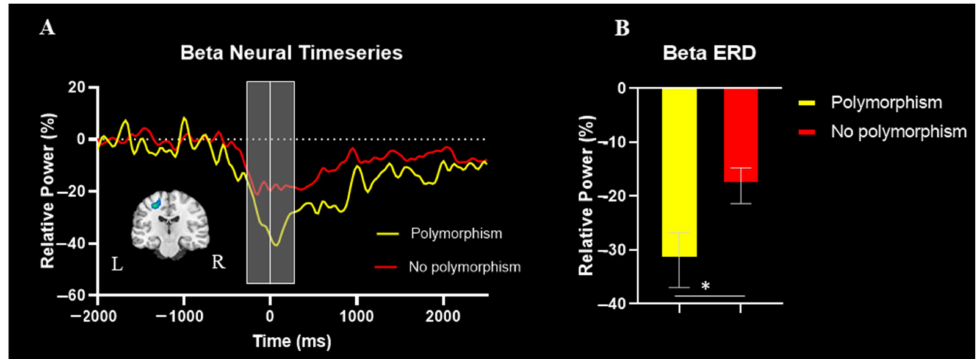
Figure 3. ( A ) Group averaged beamformed image of the beta ERD (18–24Hz, − 250 to 250 ms) is shown in the bottom left. The neural time course reflects the response power with percent change from baseline denoted on the y-axis and time denoted on the x-axis. The time interval image is depicted by the light gray box and the white line at time zero reflects movement onset. ( B ) Bar graph representing differences in the strength of the beta ERD between the individuals with CP with and without the polymorphism. The individuals with CP who had a polymorphism at the BDNF gene had a stronger beta ERD in comparison to the individuals with CP without a polymorphism ( p = 0.042). * indicates p <